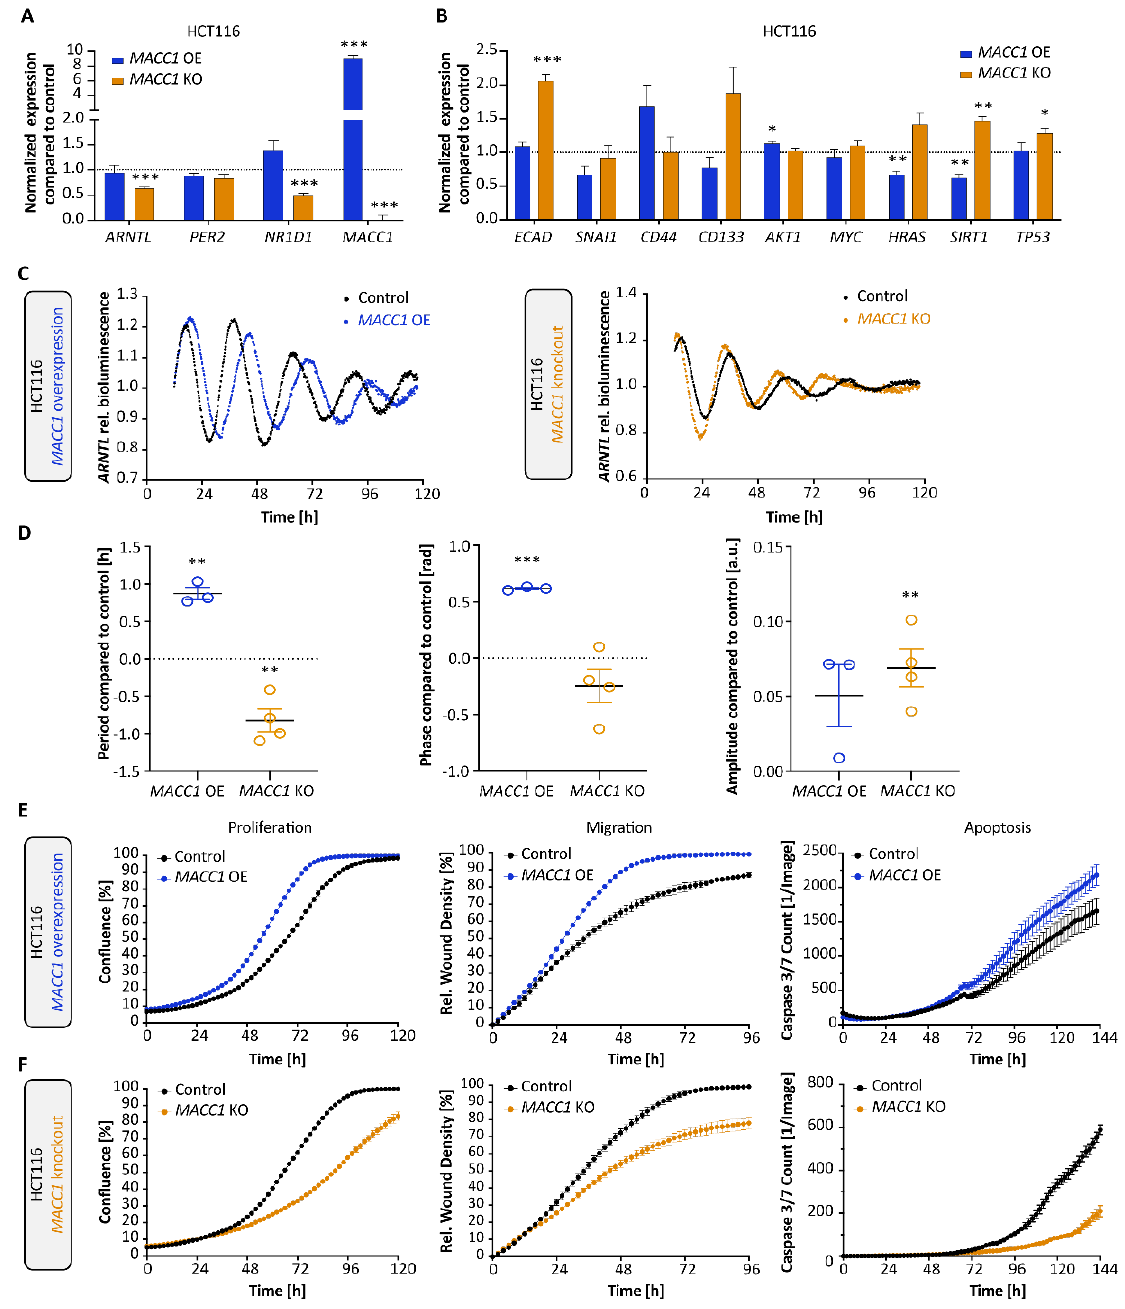
Figure 3. MACC1 manipulation affects clock phenotype in HCT116 cells. Gene expression analysis of CC genes ARNTL , PER2 and NR1D1 ( A ) as well as EMT-related genes ( B ) in HCT116 MACC1 overexpressing (OE) and MACC1 knockout (KO) cells, respectively. Samples were collected at 24 h after synchronization ( n = 3, mean ± SEM). ( C , D ) ARNTL promoter activity in HCT116 MACC1 OE and HCT116 MACC1 KO cell lines. Measurements were taken over five days using live-cell bioluminescence recordings. Period, phase and amplitude were measured using Chronostar ( n ≥ 3, mean ± SEM). T Control = 24.9 ± 0.1 h and T MACC1 OE = 25.8 ± 0.1 h, T Control = 23.5 ± 0.1 h and T MACC1 KO = 22.4 ± 0.2 h. * p < 0.05, ** p < 0.01, *** p < 0.001; two-tailed unpaired t -test. ( E , F ) Proliferation, migration and apoptosis analysis of HCT116 MACC1 OE ( E ) and HCT116 MACC1 KO ( F ) cell lines using live-cell imaging ( n > 8, mean ± SEM, significance tested by comparing AUC with the respective control cell line, two-tailed unpaired t -test).